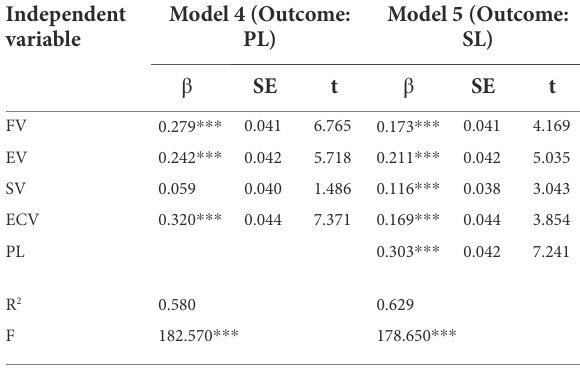
TABLE 8 Results of mediation analysis.